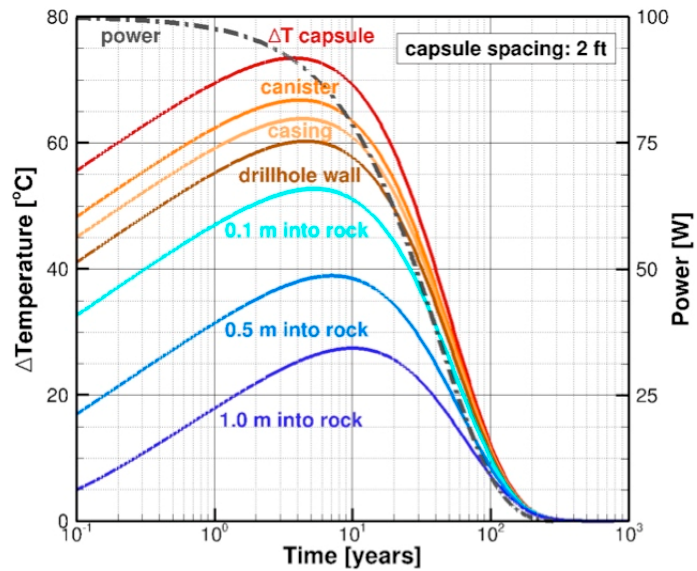
Figure 3. Evolution of temperature change and decay-heat output for an initial heat release of 100 W per waste capsule with a capsule spacing of 2 ft. (0.6096 m) [69].